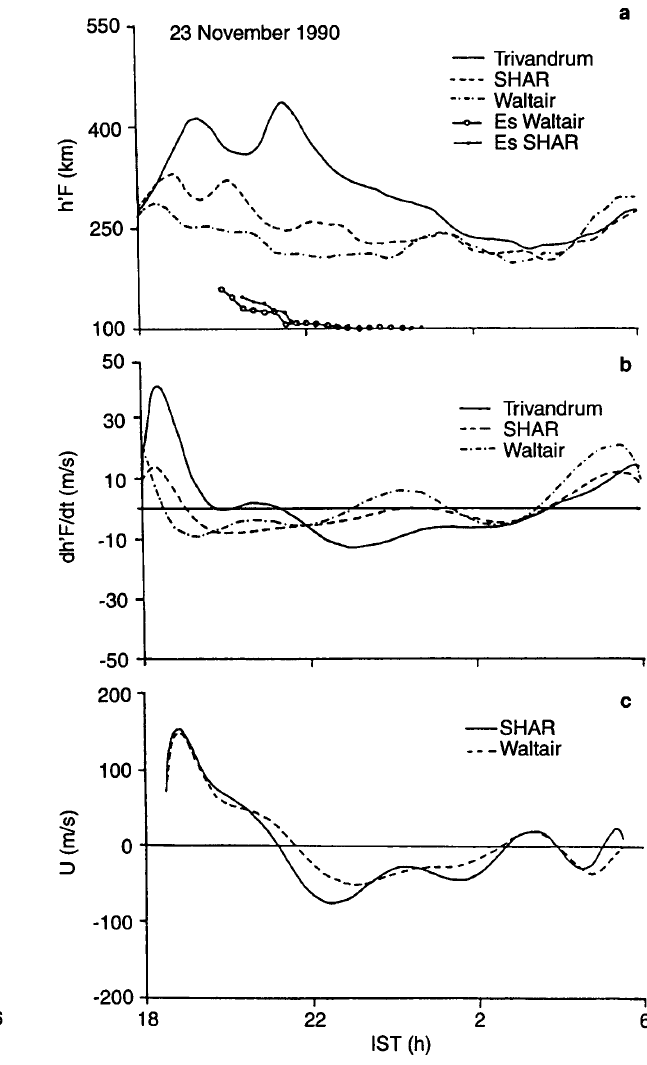
Fig. 3a–c. Variations of a h ¢ F, b V during the night of 19 November, 1990. The height of the Es layers is also indicated